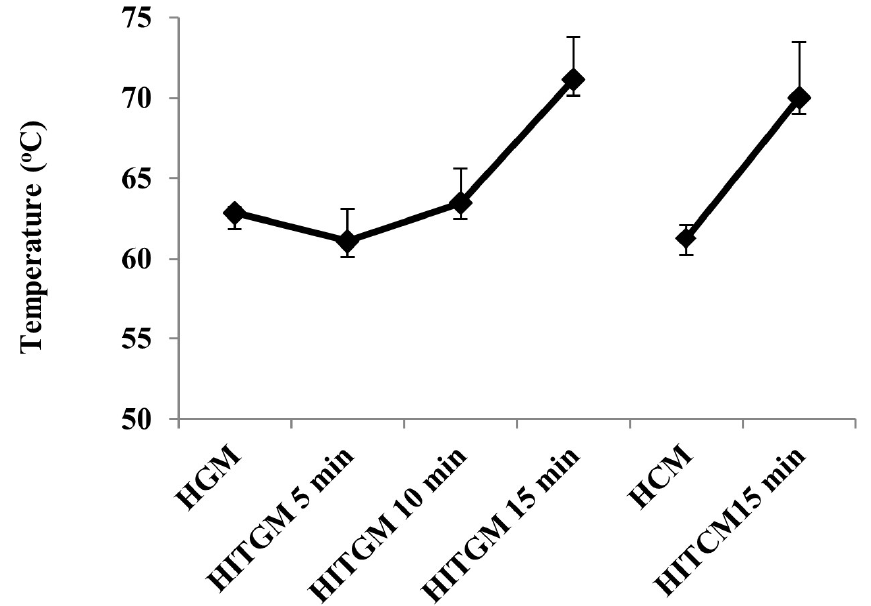
Figure 1. Changes in the temperature of goat and cow milk samples during the high-intensity thermosonication treatment. Values presented as means of triplicate ± standard deviation. HGM, homogenized goat milk; HITGM 5 min, goat milk, high-intensity thermosonicated for 5 min; HITGM 10 min, goat milk, high-intensity thermosonicated for 10 min; HITGM 15 min, goat milk, high-intensity thermosonicated for 15 min; HCM, homogenized cow milk; HITCM 15 min, cow milk, high-intensity thermosonicated for 15 min.